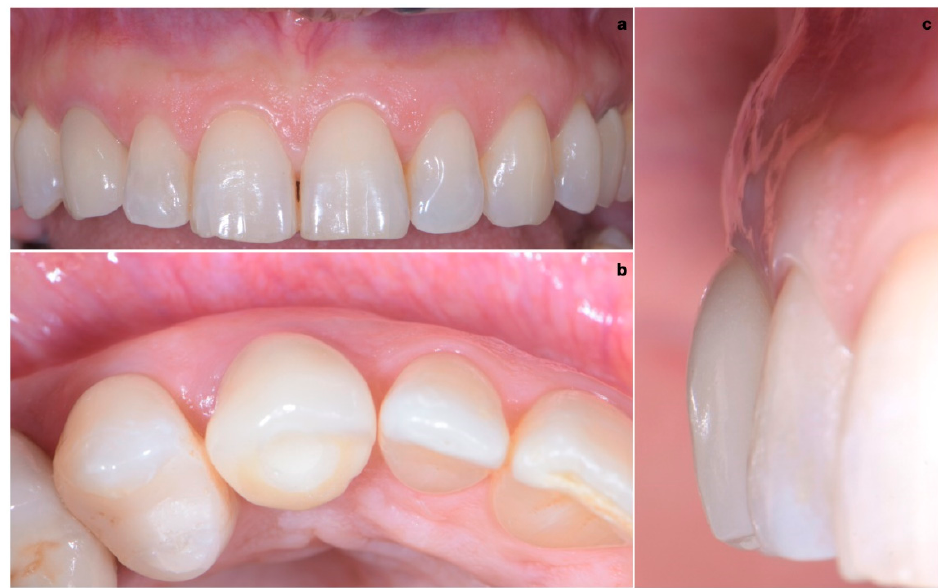
Figure 15. ( a – c ) One year after final restoration placement, the clinical outcome remained stable and fully satisfied the patient’s esthetic demands.